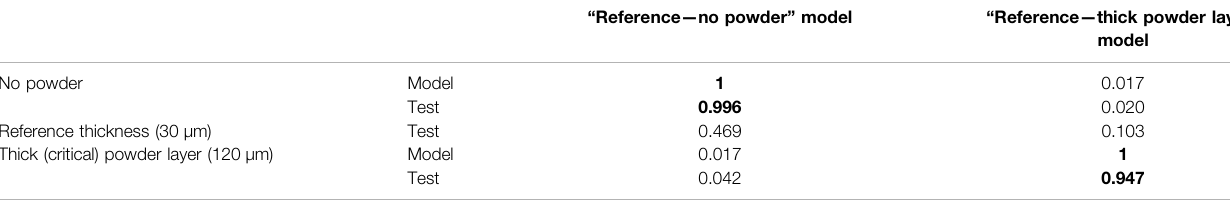
TABLE 2 | Correlation coef fi cients for model/test experiments. The values in bold are the that should correspond to that column i.e., data should correlate to that column. “ Reference — no powder ” model “ Reference — thick powder layer